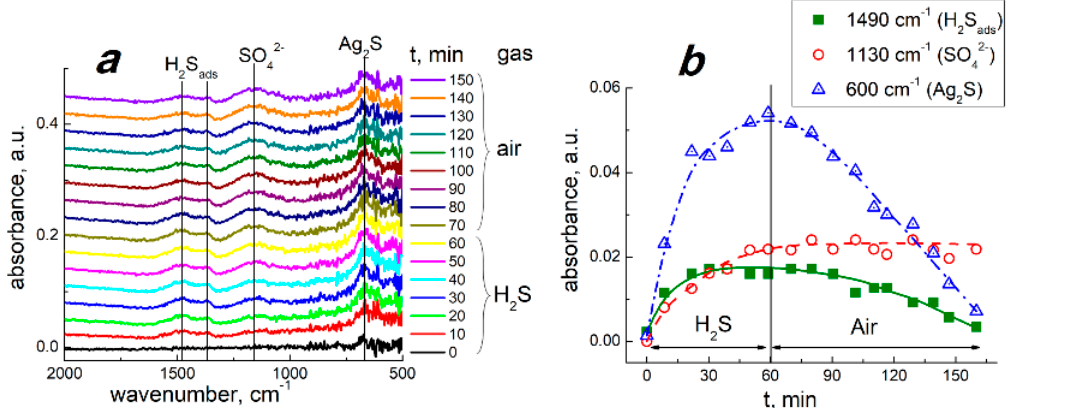
Figure 4. DRIFT spectra of Ag/LaCoO 3 exposed to 20 ppm H 2 S at 200 °C for 60 min and to air at